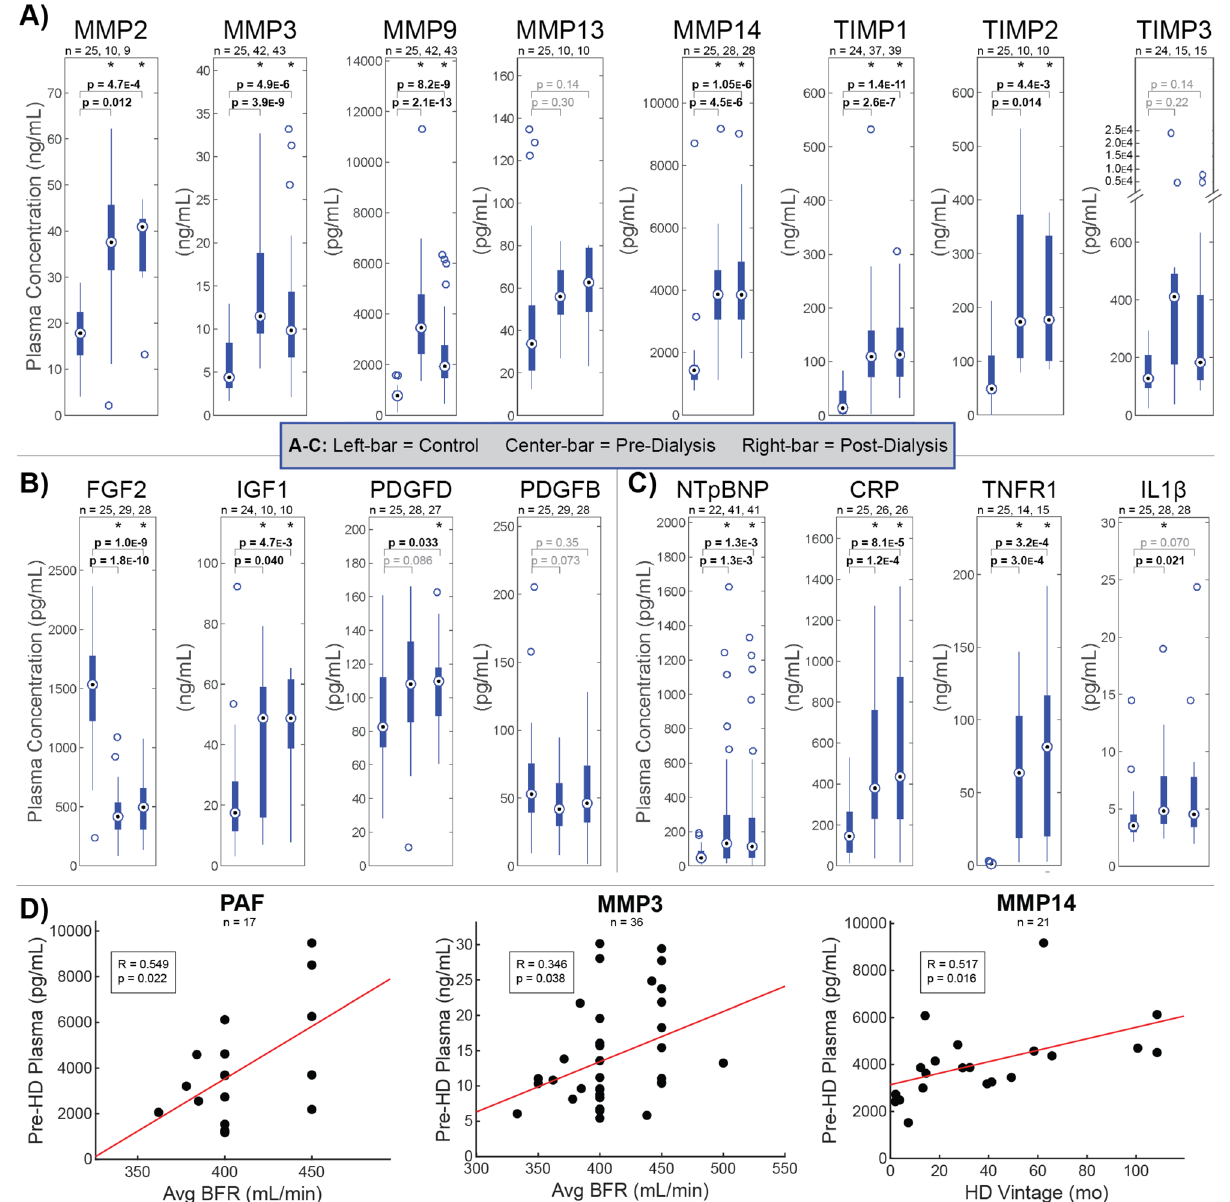
Figure 1. Hemodialysis patient plasma is characterized by proteolytic dysregulation and pro-fibrotic indicators. Comparison of plasma concentrations of ( A ) MMPs and TIMPs, ( B ) growth factors, and ( C ) inflammatory and cardiovascular markers between healthy control and pre-dialysis or post-dialysis samples as measured by ELISA and compared by t test. * p < 0.05. Box and whisker plots represent quartiles. ( A ) Concentrations of four MMPs (MMP2, MMP3, MMP9, MMP14) and two TIMPs (TIMP1, TIMP2) were significantly elevated in dialysis patients both before and after HD compared to healthy controls. ( B ) Significantly depressed FGF2 and significantly elevated IGF1 in dialysis patients indicate a pro-fibrotic circulatory phenotype. ( C ) Natriuretic peptides and inflammatory markers are elevated in dialysis patients as established indicators of adverse cardiovascular outcomes. ( D ) Significant Pearson correlations ( p < 0.05) between pre-dialysis plasma concentrations and treatment parameters blood flow rate (BFR) and dialysis vintage. Positive relationships against PAF and MMPs support worsening proteolytic and coagulative dysfunctions with BFR and Vintage. Figure was prepared in Matlab R2019 (Mathworks, Nattick MA, www. mathw orks.